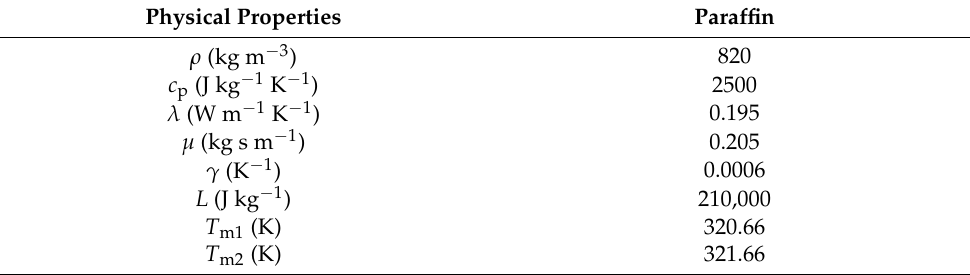
Table 1. Physical properties of paraffin